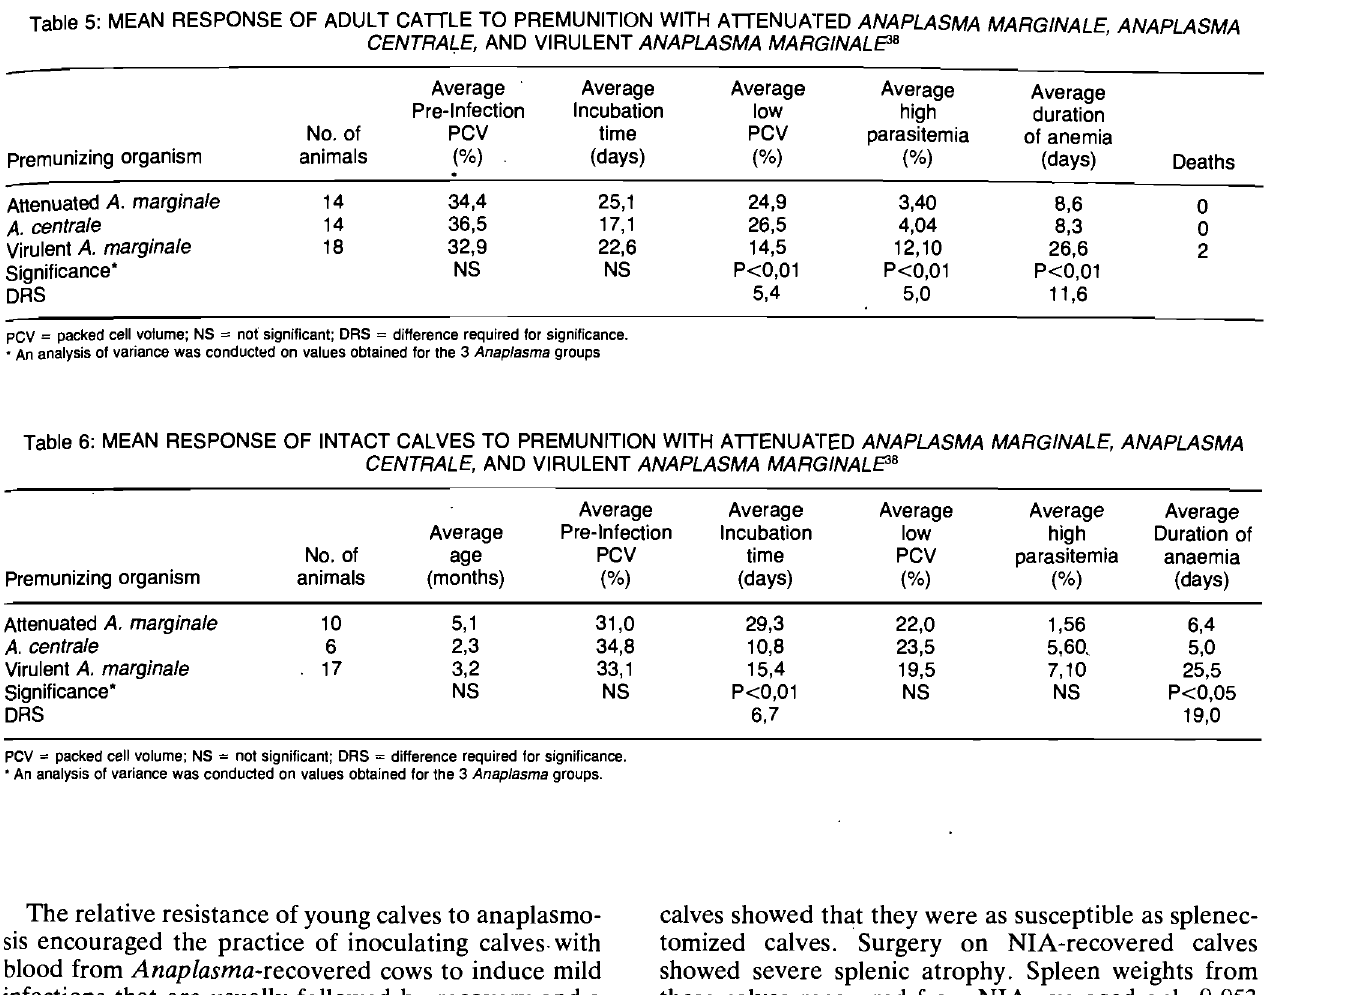
Table 5: MEAN RESPONSE OF ADULT CATTLE TO PREMUNITION WITH ATTENUATED ANAPLASMA MARGINALE ANAPLASMA CENTRA~E, AND VIRULENT ANAPLASMA MARGINALE?8